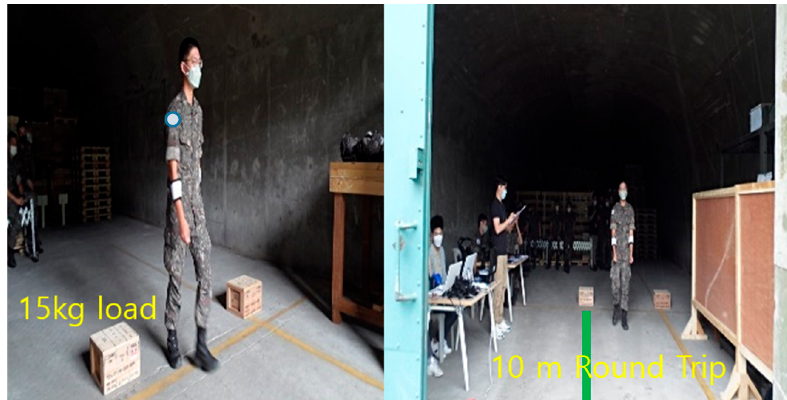
Figure 2. Not equipped with the LEXO-W without any load.